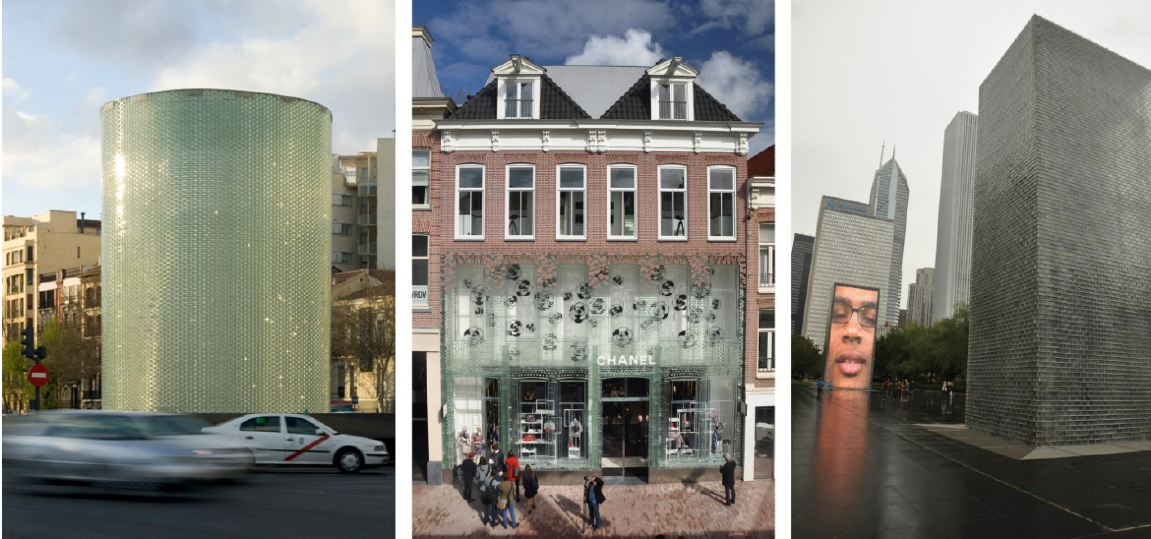
Fig. 1: Some of the most characteristic examples of structures out of cast glass blocks: The adhesively bonded Atocha Memorial (left) and Crystal Houses (centre), and the Crown Fountain (right) which is supported by a metal substructure.